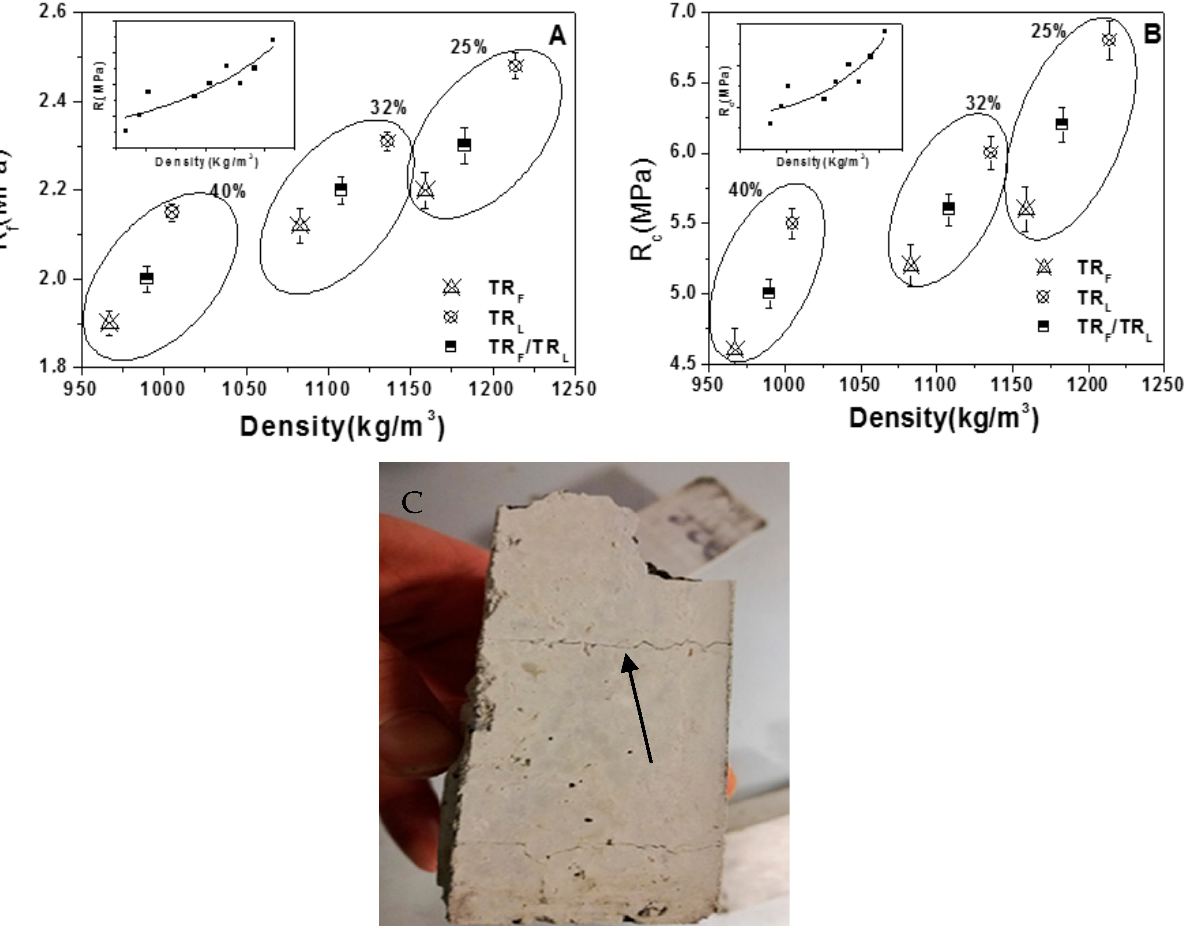
Figure 3. ( A ) Flexural and ( B ) compressive strengths of the TR mortars. The Rf and Rc of the control sample were, respectively, 8 ± 1 MPa and 45 ± 2 MPa. ( C ) Discrete cracks after rupture in the TR specimens (evidenced by the arrow), with the two parts of the sample still connected by tire rubber.